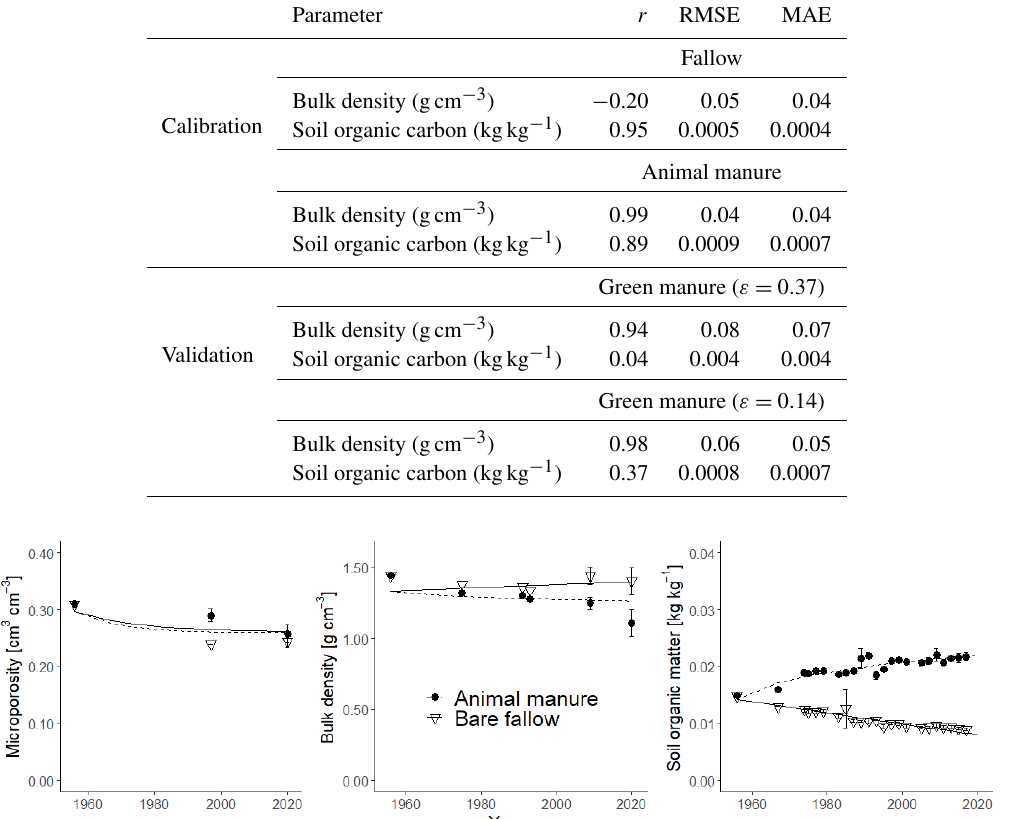
Table 5. Goodness of fit of the model simulations to observed bulk density and soil organic carbon concentration. Note: r – correlation coefficient, RMSE – root mean squared error and MAE – mean absolute error.